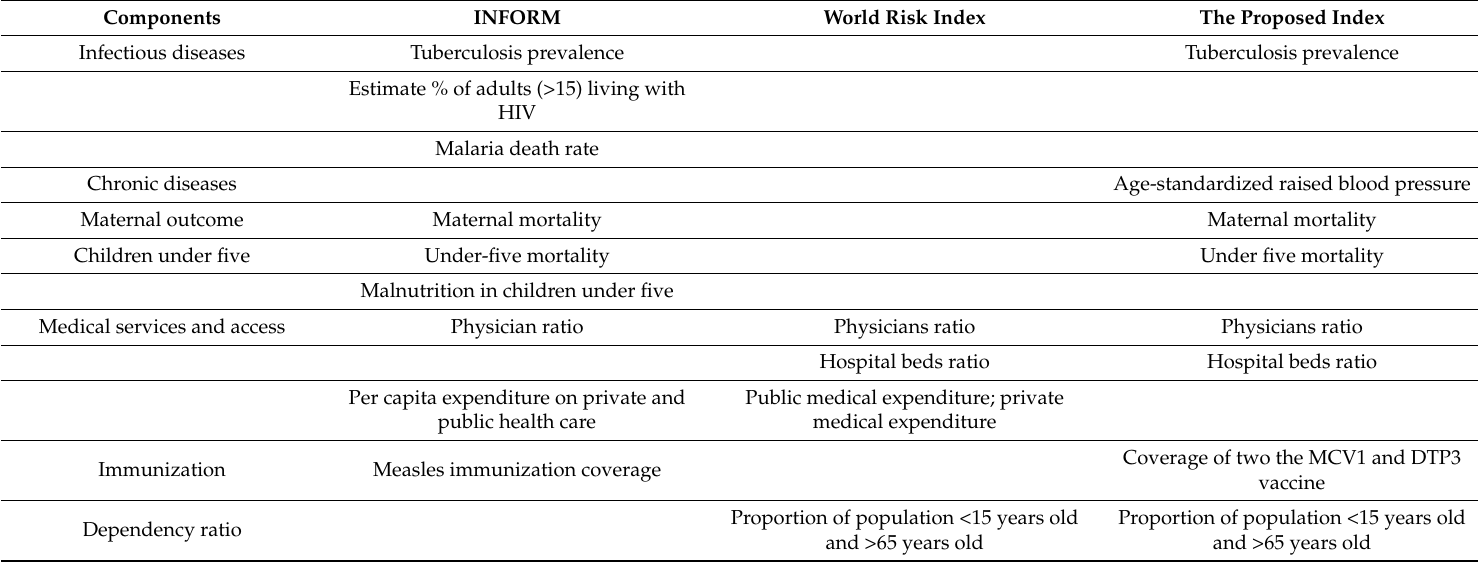
Table 2. Health-related components considered in the Index For Risk Management (INFORM) model, the World Risk Index, and the index developed in this study.